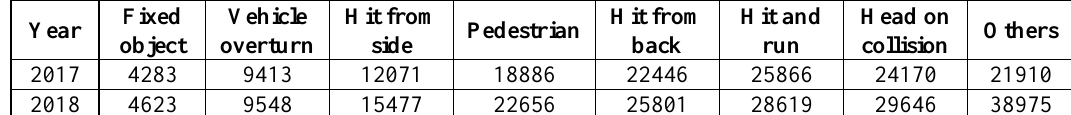
Table 13: Road accident deaths based on type of collision.